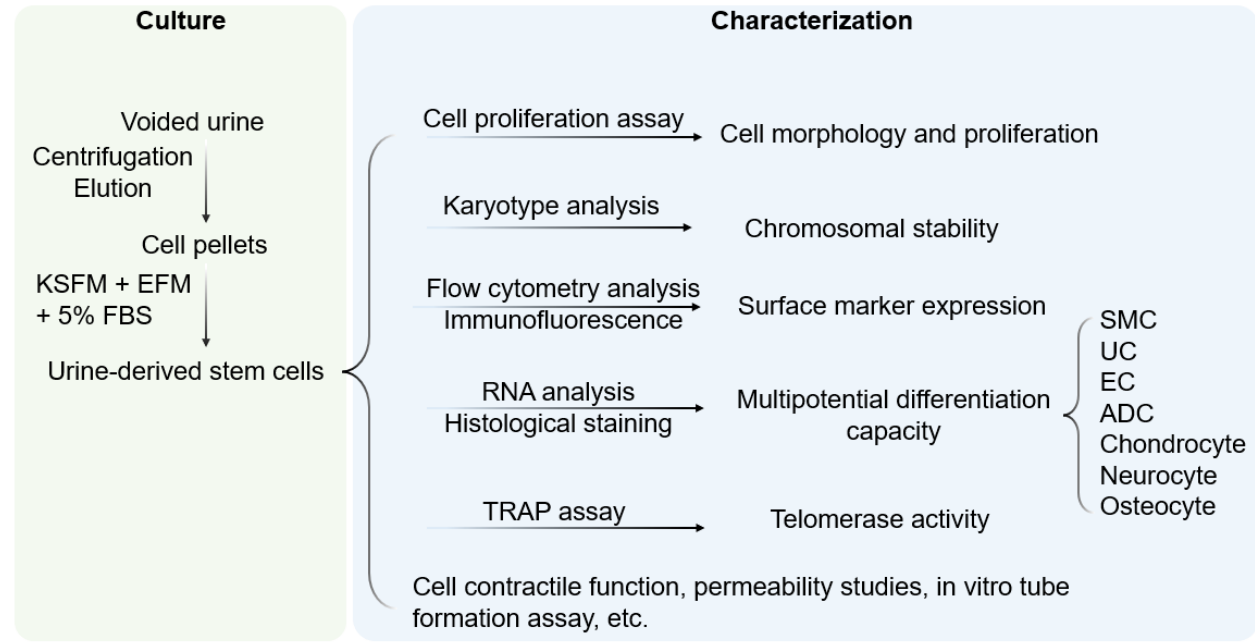
Figure 1. Culture and characterization of USC. Voided urine is collected from individuals, followed by centrifugation and elution, after which USC pellets are obtained. Under proper culture conditions, USC becomes rice-grain shaped in 3–7 days, and gradually obtains distinct morphology of induced lineages when cultured in a related differentiation medium. KSFM, embryonic fibroblast medium; EFM, keratinocyte serum-free medium; FBS, fetal bovine serum; SMC, smooth muscle cells; EC, endothelial cells; ADC, adipocytes; TRAP, telomerase repeated amplification